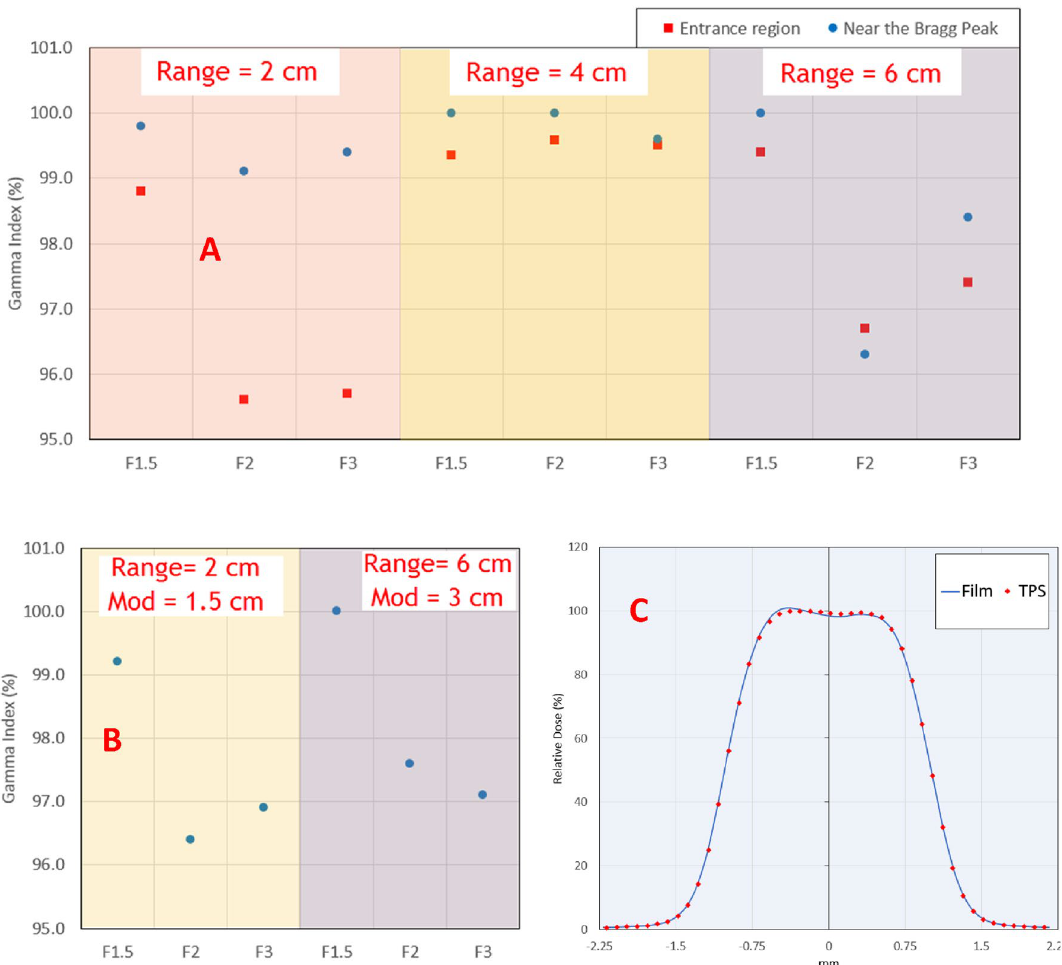
Figure 4. ( A ) Gamma Index analysis for Bragg peak beams at the entrance region and a depth near the Bragg peak, as a function of the field size. ( B ) Gamma Index analysis for SOBP beams at depths corresponding to the center of the SOBP as a function of the field size. ( C ) An example dose profile in the center of the SOBP for a field with a 2 cm circular